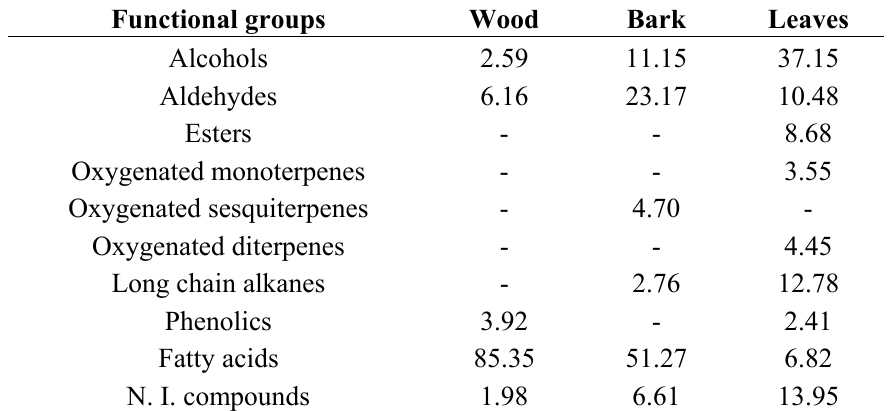
Table 2. Classification of compounds in the essential oil from different parts of C. bakeriana by functional groups (N.I. = not identified).